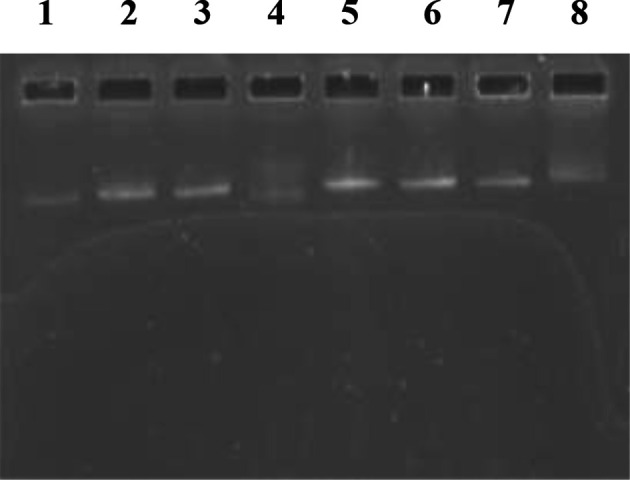
Plasmid profile of sewage wastewater bacterial isolates: lane 1,
E. coli
 ST2; lane 2,
E. coli
 ST3; lane 3,
E. coli
 ST4; lane 4,
E. coli
 ST4 (cured strain); lane 5,
E. coli
 V517 (≈54 kb) standard molecular marker; lane 6,
A. baumannii
 ST1; lane 7,
P. putida
 ST6; lane 8,
P. putida
 ST6 (cured strain). Note the presence of chromosomal DNA smears and the absence of plasmid DNA bands in cured bacterial strains (lanes 4 and 8).